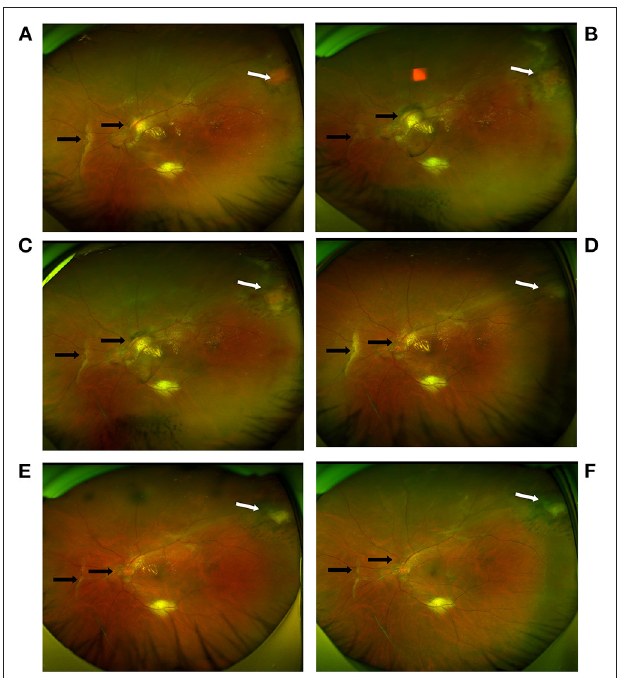
FIGURE 2 | Ultra-widefield fundus photography imaging before and after LP in the left eye. (A) A pink elevated tumor located in the superotemporal retina (white arrow). Vitreoretinal and disc traction (black arrow), vitreous hemorrhage and macular exudation were also observed. (B,C) At the 2-week and 1-month follow-up appointments after the first round of LP, the tumor thickness decreased, although the tumor existed (white arrow). Vitreoretinal and disc traction persisted (black arrow). (D–F) At 1 month, 5 months and 1 year after the second round of LP, the tumor disappeared and did not recur (white arrow). Vitreoretinal traction gradually reduced (black arrow). Macular exudation gradually disappeared.